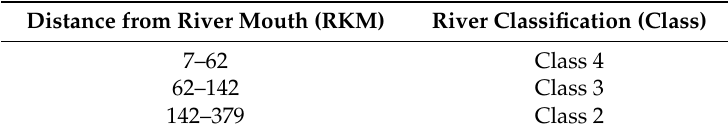
Table 2. Classification of Chao Phraya River by Thailand